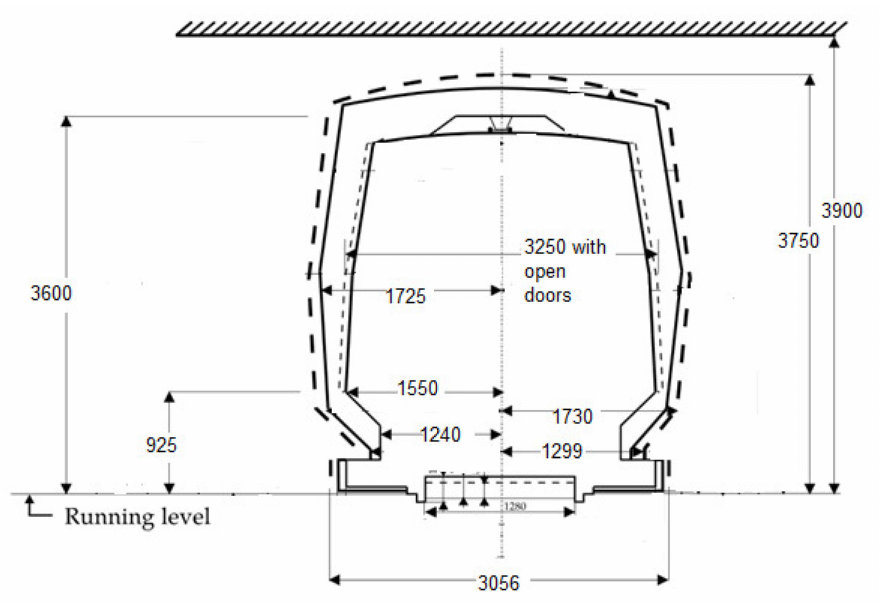
Figure 3. Shape and main dimensions for the Bucharest Underground Gauge (transversal section,